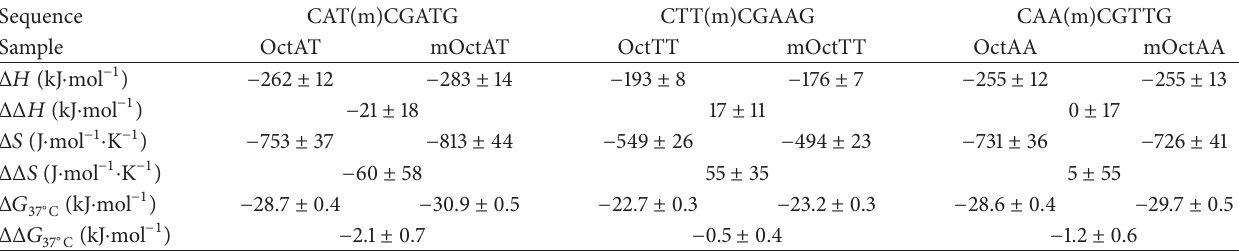
Table 2: Thermodynamic characteristics of duplex formation and effect of the cytosine methylation.